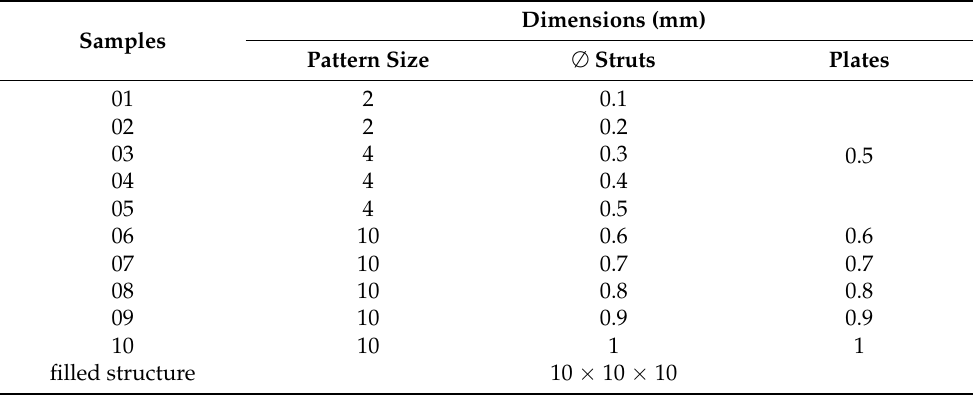
Table 1. Geometric parameters of the different